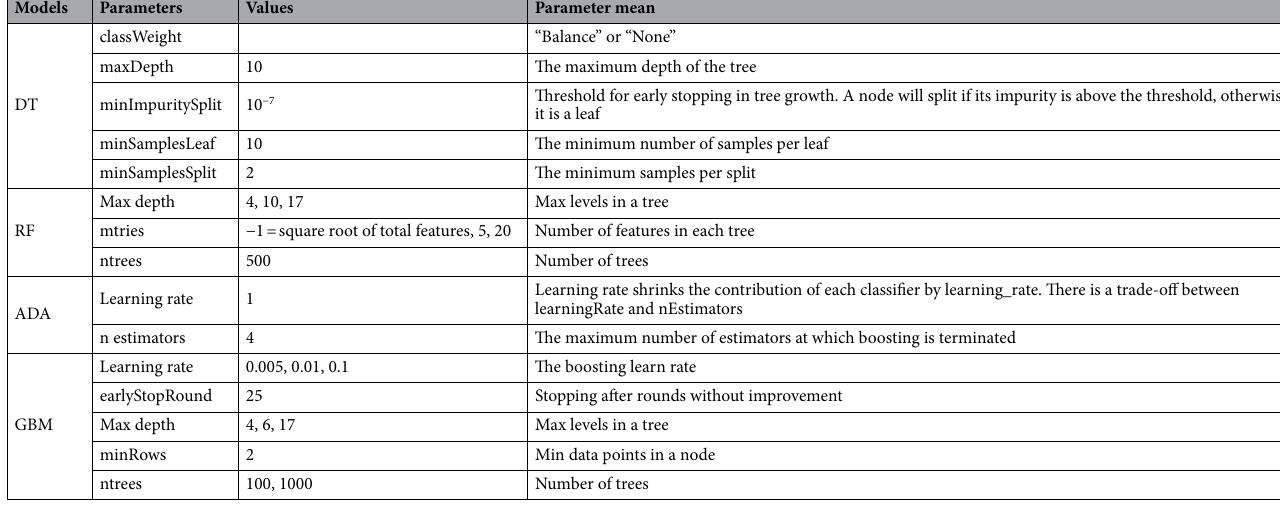
Table 5. Summary of parameter values in each